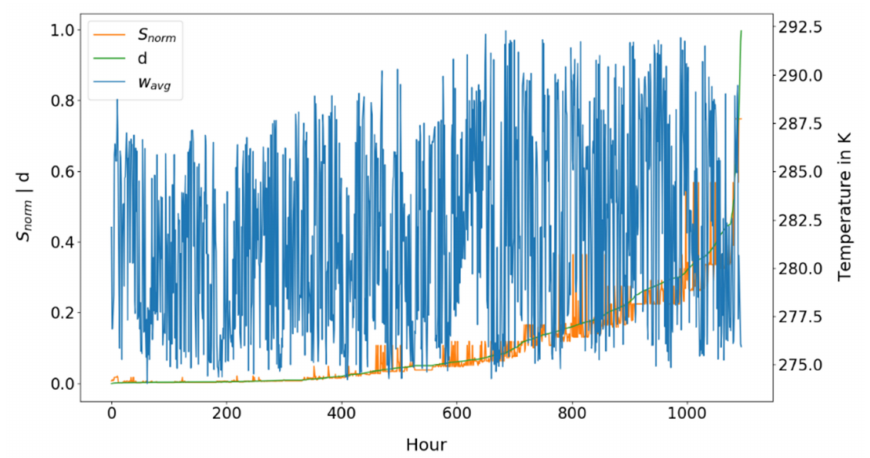
Figure A2. Example of the training data of our neural network for the device cooking, ordered by d . Only every eighth hour is shown to increase the visibility. We train the neural networks to predict d from S norm and w avg and, therefore, correlate consumption data with input data that are available comprehensively. In this case of cooking, d is strongly dependent on S norm and less dependent on w avg